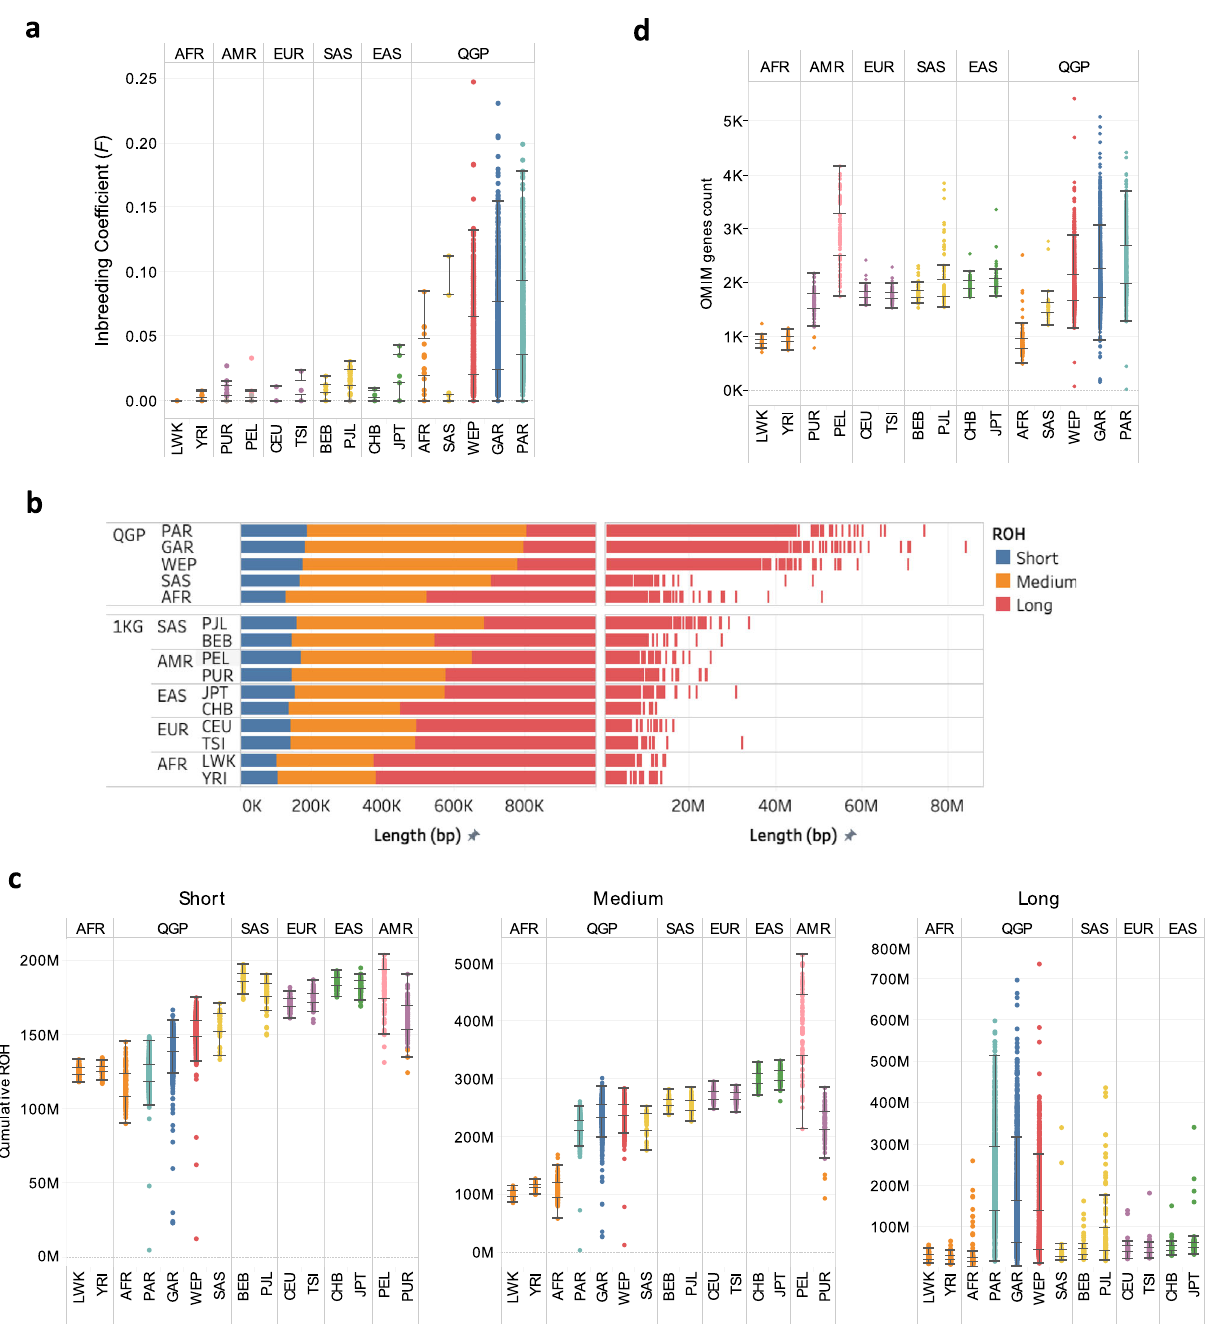
Fig. 5 Runs of homozygosity and relatedness in QGP in the context of world populations. a Distribution of inbreeding coef fi cient ( F ) in QGP and reference world populations. b Distribution of ROH segments ordered and colored by size class, highlighting a shift in ROH class boundaries towards longer ROH for medium and long classes for the QGP subpopulations in comparison to the 1KG populations. c Cumulative size of short, medium and long ROH segments across individual samples based on Gaussian mixture model clustering highlighting considerably more samples enriched for long ROH in QGP PAR, GAR and WEP subpopulations. Populations are sorted by ascending median of cumulative medium ROH. d Count of OMIM genes that completely overlap with ROH per population. Populations are ordered as in a . Numbers of samples used for QGP are AFR n = 179, GAR n = 2338, PAR n = 1073, SAS n = 40, WEP n = 1390 and for 1KG are BEB n = 86, CEU n = 99, CHB n = 103, JPT n = 104, LWK n = 99, PEL n = 85, PJL n = 96, PUR n = 104, TSI n = 107, YRI n = 108. Boxes indicate median and middle two quartiles of the data. Whiskers indicate data 1.5 times the interquartile range. Abbreviations of 1KG populations are explained in Supplementary Table 2. Source data are provided as a Source Data fi